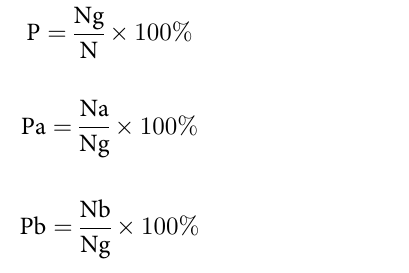
Note: P is the common peak rate of the two samples; N is the number of independent peaks in the two samples; Ng is the common peak number of the two samples; Pa is the variation peak rate of the sample; Na is the variation peak rate of the sample; Pb is the variation peak rate of sample B; Nb is the variation peak number of sample B, which conforms to N = Ng + Na + Nb. The common peak rate and variation peak rate of the infrared spectrum between M1 and M18 were determined using (1)–(3), and the Rhubarb double index analysis sequence was cre- ated. The sequence has great identification ability and can accurately estimate the genetic dis- tance between all samples in the 2+n-dimensional (n = number of samples) space [39]. Ma: Mb (P; Pa, Pb) is the double index analysis sequence of the common peak rate and variation peak rate, which implies that with Ma as the control medication, the common peak rate of Mb is P, the variation peak rate of Ma is Pa, and the variation peak rate of Mb is Pb.